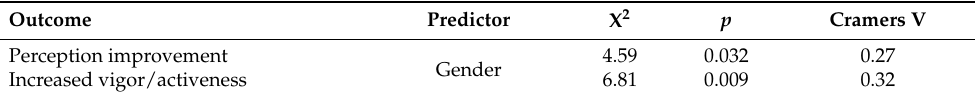
Table 3. Association between Gender predictor and certain POSITIVE effects 60 min after CAF ingestion.